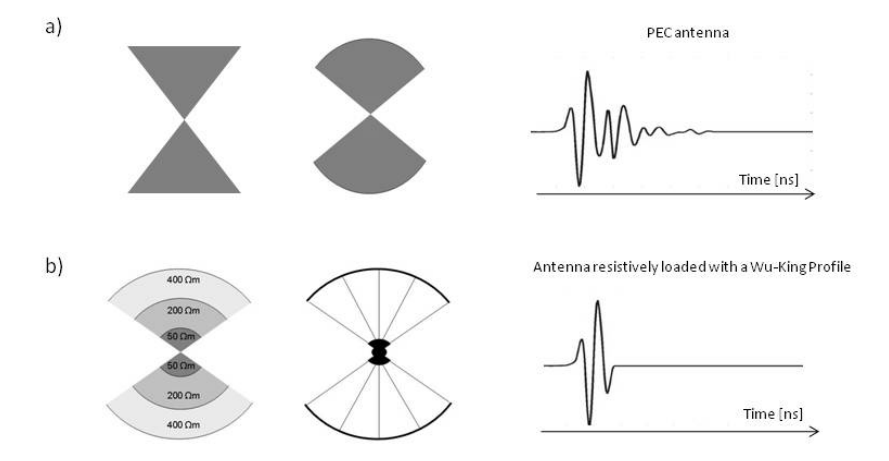
Figure 4 . Examples of variation in the bowtie antenna design. (a) Bowties existing on almost perfect electric conductor (PEC) surfaces. (b) Bowties with resistive loaded